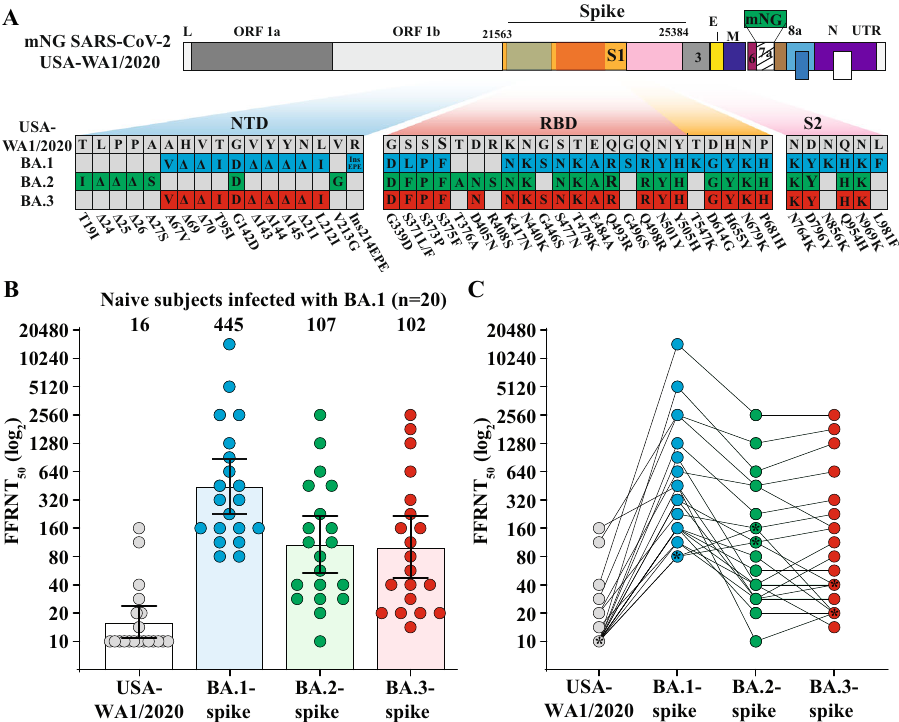
Fig. 1 Cross-neutralization of human sera from unvaccinated individuals who were infected with Omicron BA.1 SARS-CoV-2. A Omicron BA.1-, BA.2-, and BA.3-spike mNG SARS-CoV-2s. The full-length spike gene from Omicron BA.1, BA.2, or BA.3 was engineered into an mNG USA-WA1/2020 SARS- CoV-2. The mNG gene was engineered at the open-reading-frame-7 of the viral genome. Amino acid mutations, deletions, and insertions (Ins) are indicated for BA.1, BA.2, and BA.3 spikes in reference to the USA-WA1/2020 spike. L leader sequence, ORF open reading frame, NTD N-terminal domain of S1, RBD receptor binding domain of S1, S spike glycoprotein, S1 N-terminal furin cleavage fragment of S, S2 C-terminal furin cleavage fragment of S, E envelope protein, M membrane protein, N nucleoprotein, UTR untranslated region. B Scatterplot of neutralization titers. A panel of 20 human sera collected from Omicron BA.1-infected individuals were tested for the 50% fl uorescent focus-reduction neutralization titers (FFRNT 50 ) against recombinant USA- WA1/2020 (gray circles), Omicron BA.1- (blue circles), BA.2- (green circles), and BA.3-spike (red circels) mNG SARS-CoV-2s. The neutralization titer for each virus was determined in duplicates. The serum information and FFRNT 50 values are summarized in Table 1. Each data point represents the geometric mean FFRNT 50 obtained with a serum specimen against the indicated virus. The bar heights and the numbers above indicate geometric mean titers (GMTs). Error bars indicate the 95% con fi dence interval (CI) of the GMTs. Data are presented as GMT with 95% CI. Statistical analysis was performed using the Wilcoxon matched-pairs signed-rank test. Two-tailed P values of the GMT against BA.1-spike and USA-WA1/2020, BA.2-spike, or BA.3 spikes are all <0.0001. C FFRNT 50 values with connected lines for individual sera. Two sera exhibiting slightly higher FFRNT 50 s against BA.2 virus than that against BA.1-spike SARS-CoV-2 are indicated by symbol asterisk (serum ID 1 and 2 in Table